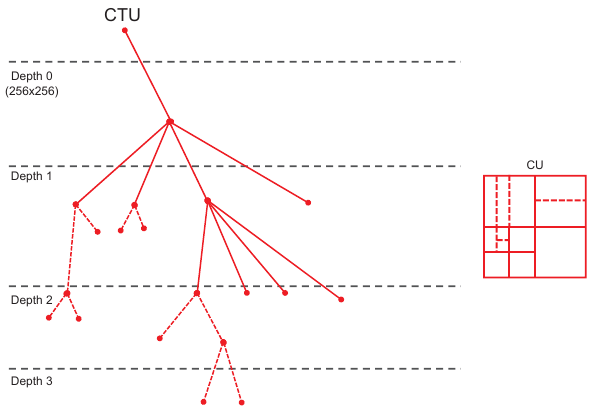
Figure 3. JEM QTBT partition